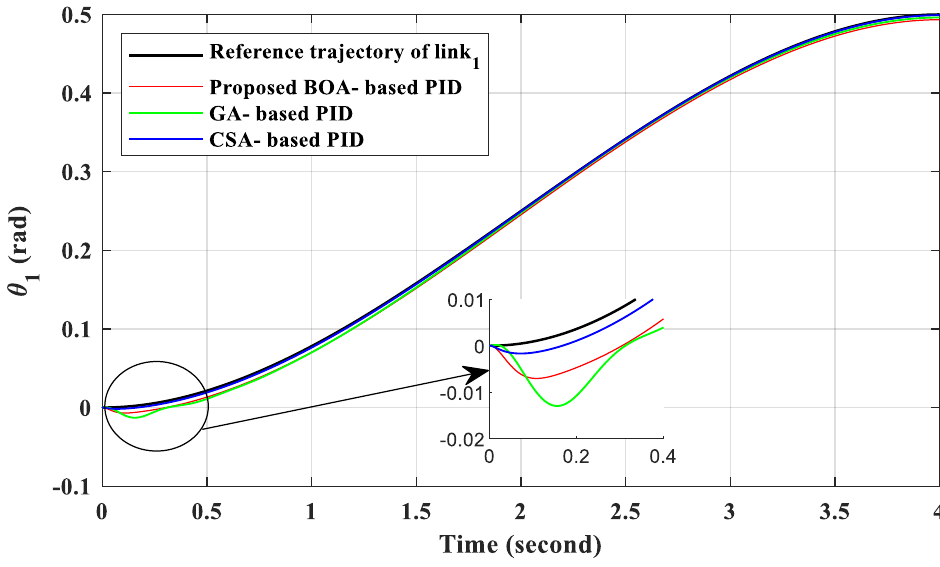
Figure 9. The output position due to link 1 in the case of cubic reference.